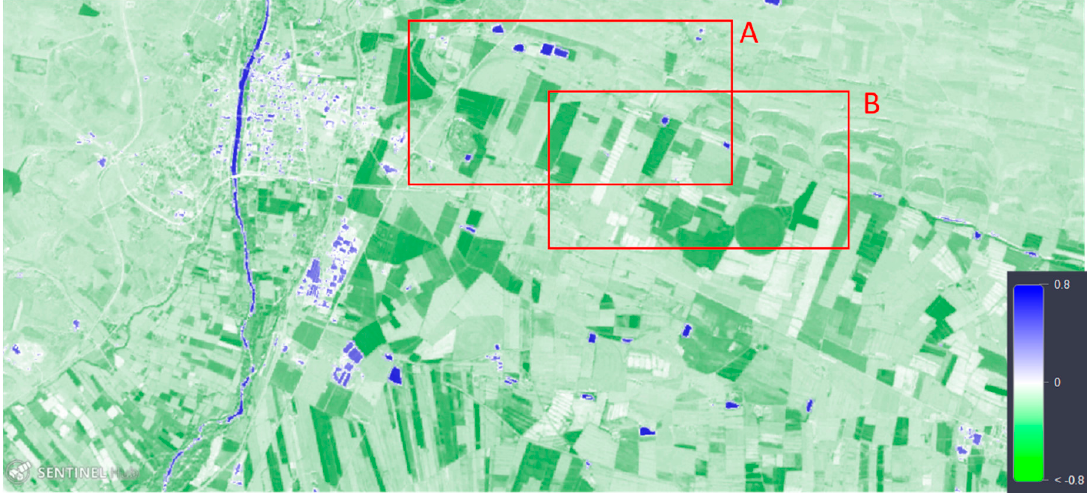
Figure 9. Sentinel-2 L1C Normalized Difference Water Index (NDWI) for October 23rd, 2018. Red rectangles correspond to regions in Figure 8.